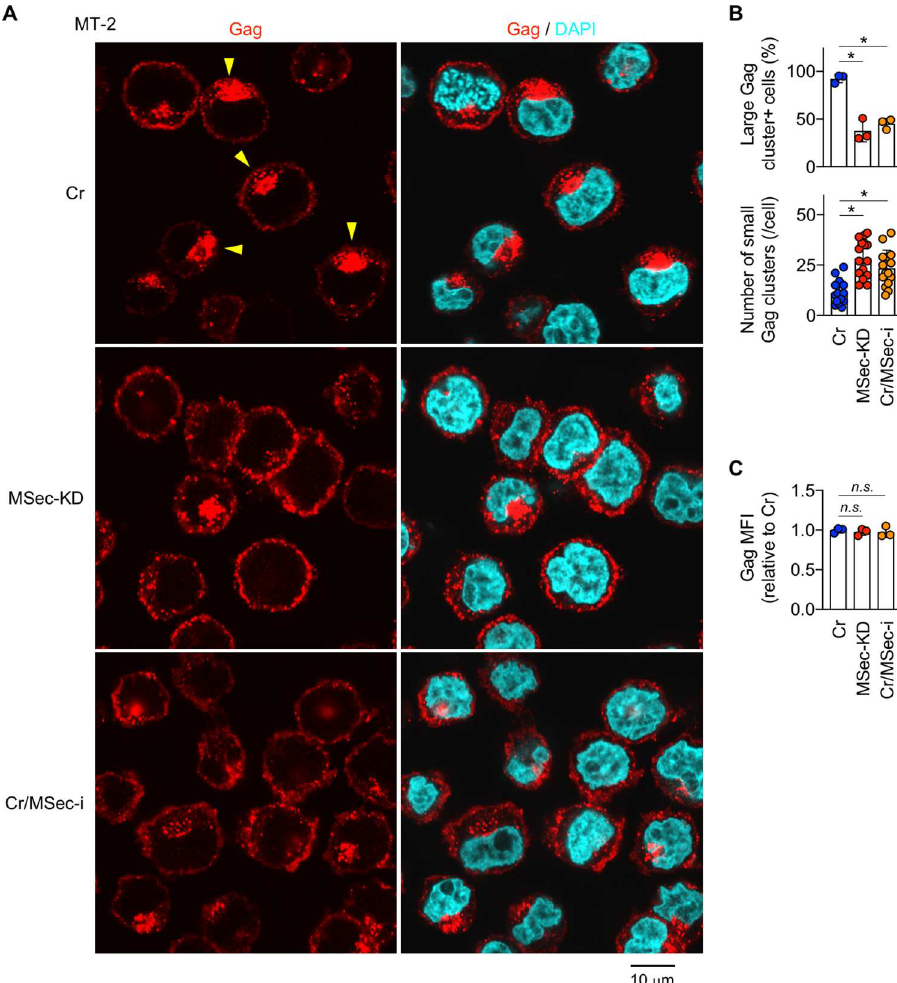
Fig 8. Effect of M-Sec knockdown/inhibition on the intracellular distribution of Gag in MT-2 cells. ( A ) The control (Cr)- or M-Sec knockdown (MSec-KD) MT-2 cells, or control cells pre-treated with M-Sec inhibitor for 48 h (Cr/MSec-i) were analyzed for Gag (red). The nuclei were also stained with DAPI (blue). Yellow arrowheads (top left panel) indicate the large Gag clusters. Scale bar: 10 μ m. ( B ) Cells were analyzed as in ( A ). Three different fields were randomly selected, and the percentages of the large Gag cluster + cells were quantified (upper). The numbers of small clusters of Gag per cell are also shown (lower, 16 cells for each). � p < 0.05. ( C ) Cells prepared as in ( A ) were analyzed for Gag expression by flow cytometry. The mean fluorescence intensities (MFI) of Gag are shown by setting the value of M-Sec inhibitor-free control cells as 1 (n = 3). n . s ., not significant.